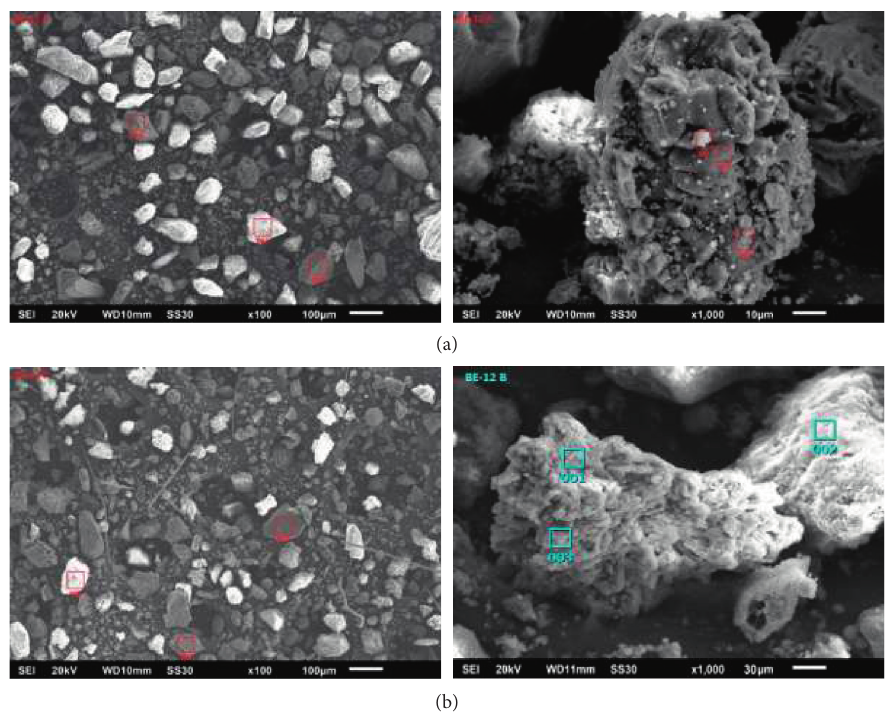
Figure 7: Comparison of 100x and 1,000x magnification of BD-3B at (a) 550 ° C and (b) 600 ° C.